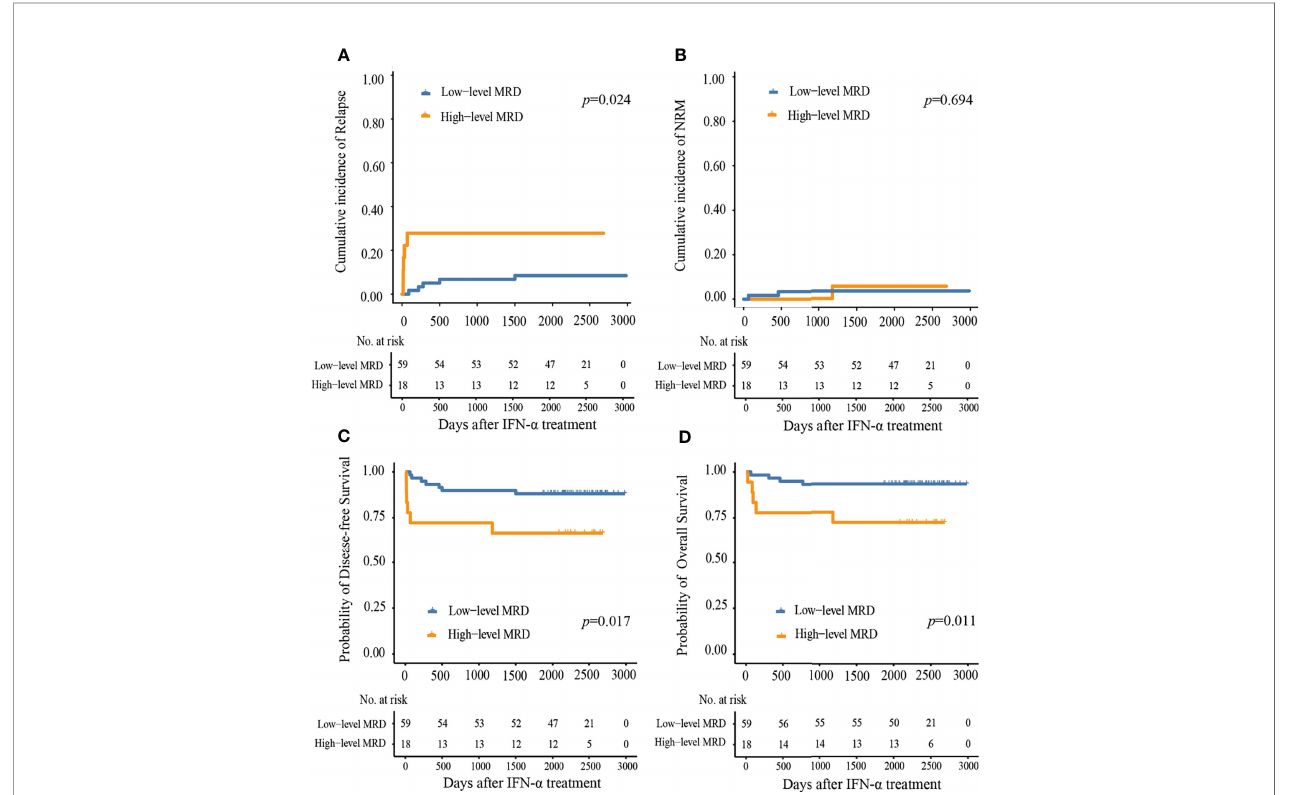
FIGURE 4 | Cumulative incidence of (A) relapse, (B) non-relapse mortality, (C) disease-free survival, and (D) overall survival at 6 years after preemptive IFN- a therapy in the low- and high-level MRD